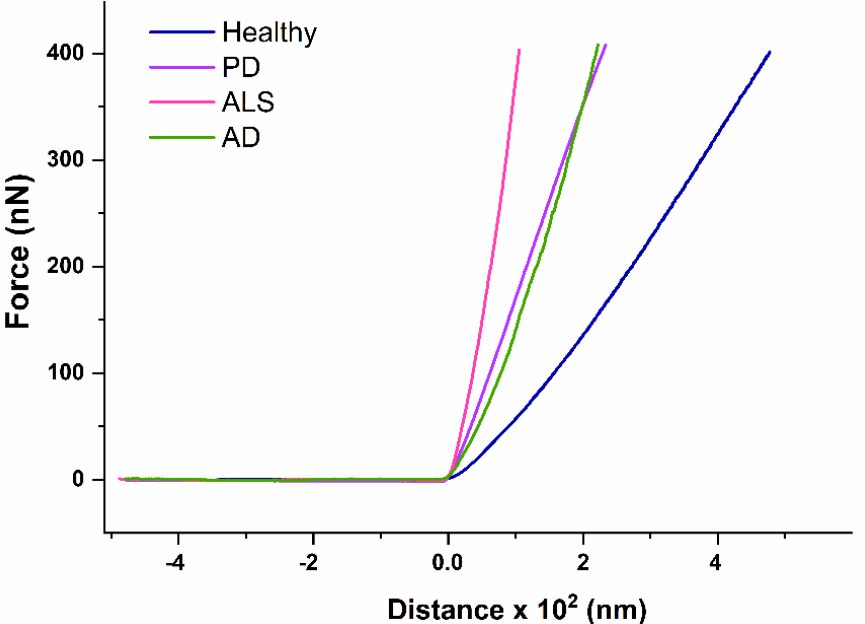
Figure 7. Representative force-distance curves of RBCs derived from healthy individuals and patients diagnosed with PD, AD and ALS.